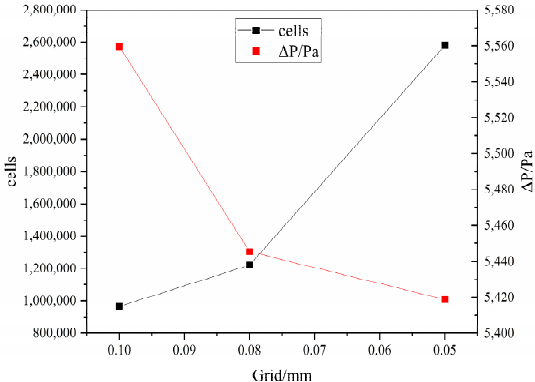
Figure 4. Grid independence verification.